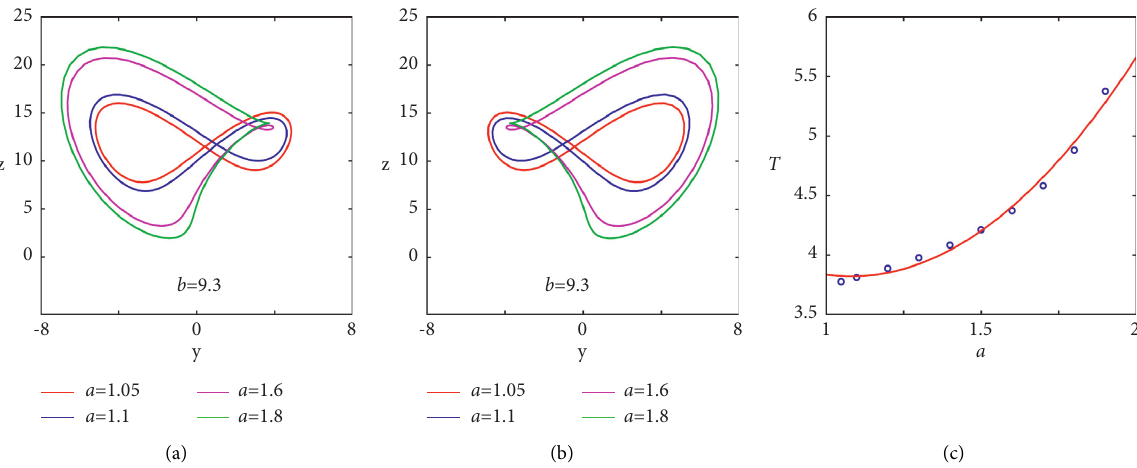
Figure 14: (a, b) Homotopy evolution of cycles 2 and 3 for different a values. (c) Periods of cycle 2 for different a values. A quadratic curve fitting method was adopted to calculate the approximate relationship between